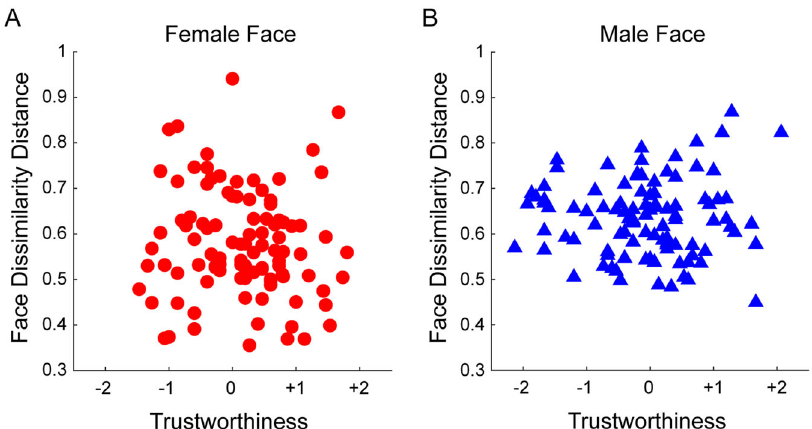
Fig. 3 Relationship between the trustworthiness score and the face dissimilarity distance from the average face for each sex. Datasets for A female and B